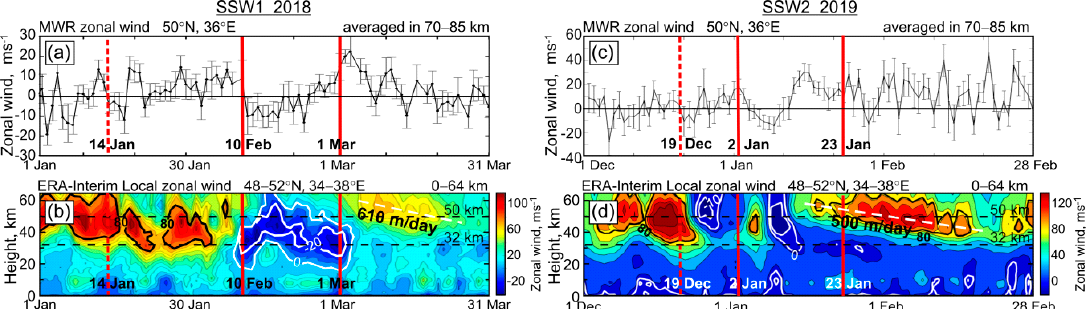
Figure 4. Zonal wind variability in ( a , b ) SSW1 in January–March 2018 and ( c , d ) SSW2 in December 2018–February 2019 by ( a , c ) the MWR data averaged in the altitude range of 70–85 km; and ( b , d ) time–altitude sections of the ERA-Interim [40] zonal wind averaged over latitudes 48–52 ◦ N and longitudes 34–38 ◦ E (centered at the Kharkiv microwave radiometer site; 50 ◦ N, 36 ◦ E). The vertical bars in ( a , c ) are standard deviations that reflects the wind speed variability at daily timescale. The SSW events are bounded by red vertical lines. Dashed vertical lines in ( c , d ) mark the start date of zonal wind reversal in December 2018 and 2019. Dashed horizontal lines in ( c,d ) mark the stratopause level at ~50 km and middle stratosphere level at ~32 km. Plots ( a , b ) modified from Wang et al. [26], their Figure